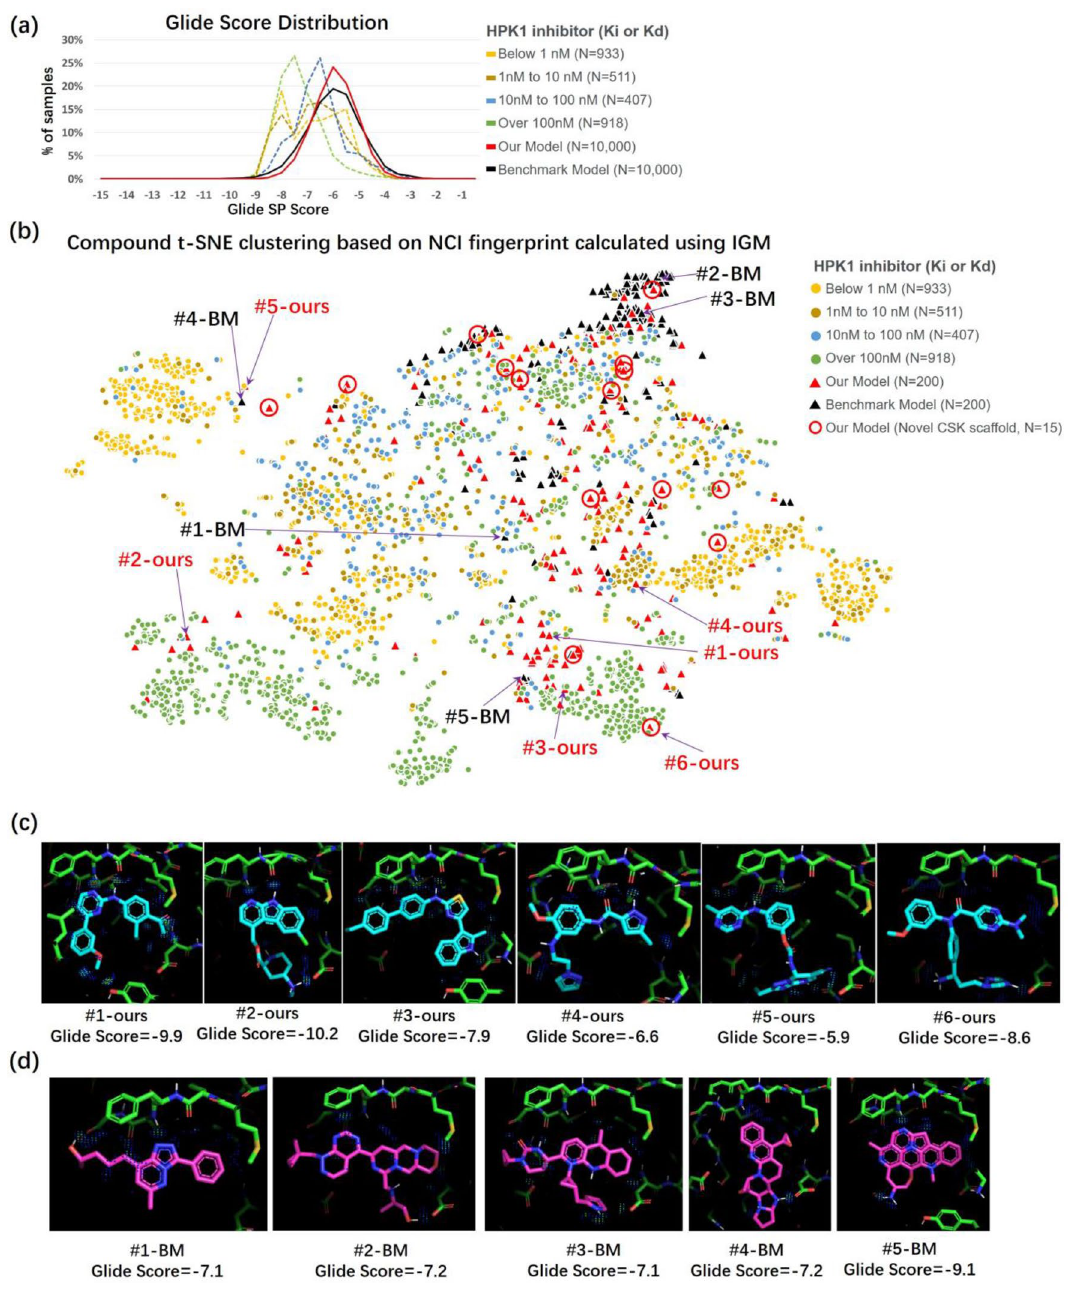
Figure 5. Binding mode analysis of the generated molecules for HPK1. ( a ) Glide Score distribution for active reference compounds and generated molecules. ( b ) Results of t-SNE clustering using IGM calculated NCIs as features. Red circles are used to indicate our generated molecules with novel cyclic skeletons 33 (CSK) with respect to reference compounds. A generated molecule is defined as having novel CSK if the highest Tanimoto similarity between its CSK and that of all the reference compounds is less than 0.5. ( c ) Binding mode of selected molecules generated by our model. ( d ) Binding mode of selected molecules generated by benchmark model. For panel c and d, NCI regions are indicated with dots colored using the rainbow scheme, in which blue indicates weak interactions and red indicates strong interactions. More details are provided in Supplementary material 4, 5, and